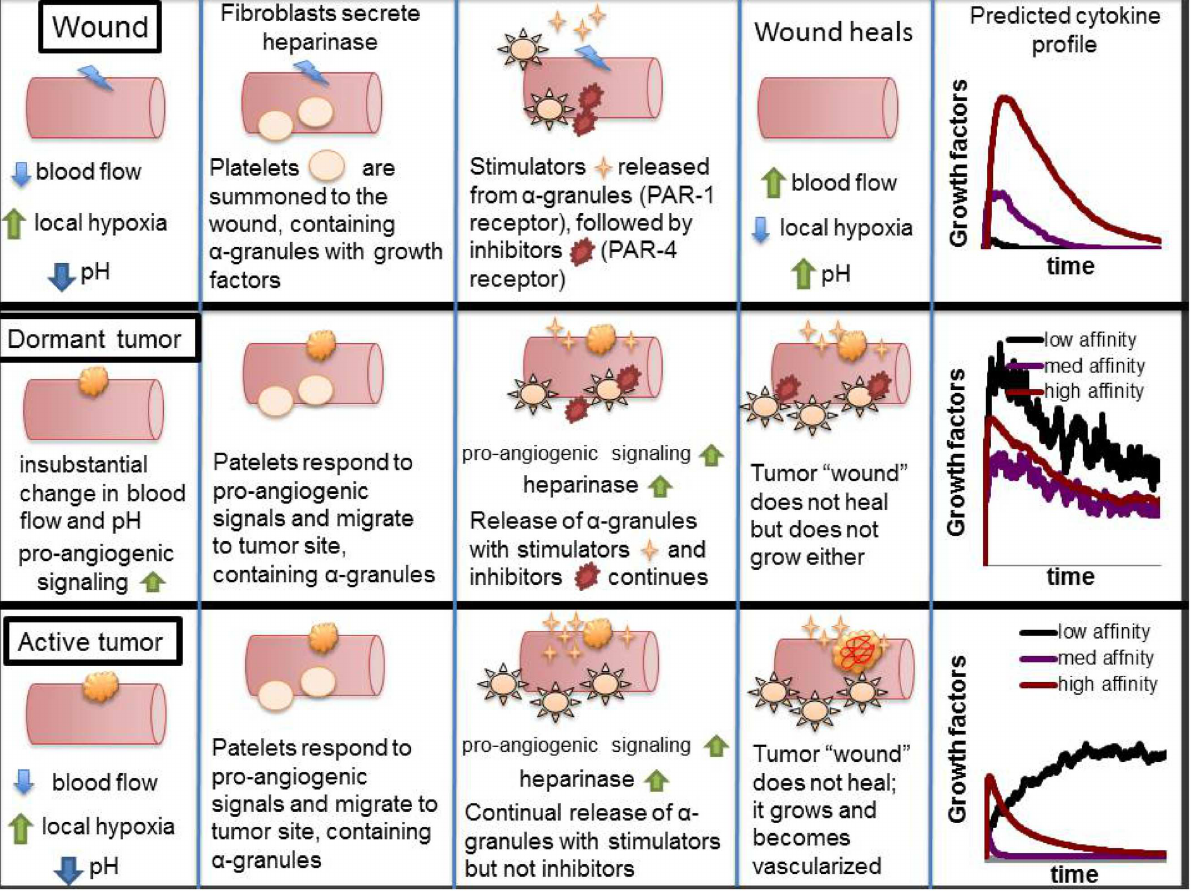
Fig 5. Schematic representation of the proposed mechanism underlying normal wound healing, pathological angiogenesis and differences in both dormant and progressive tumors.